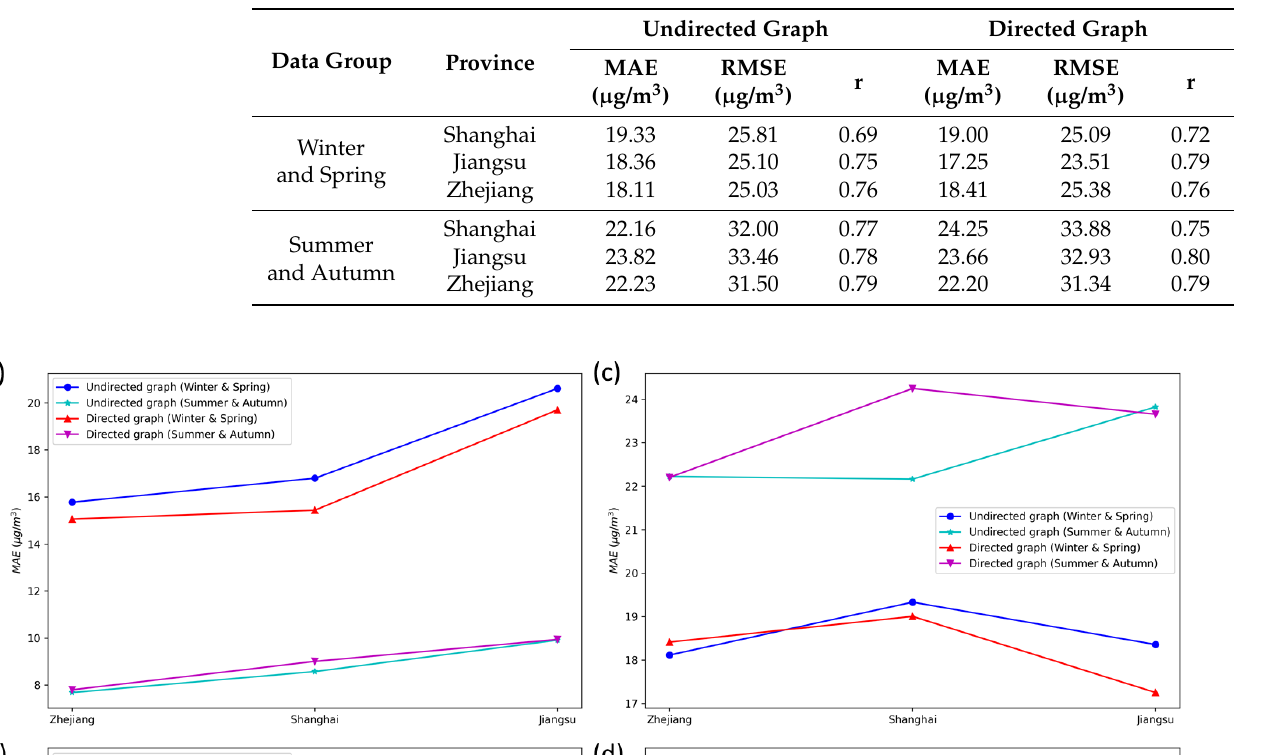
Table 6. The performance of the DCRNN model in forecasting ozone concentrations in different geographical areas.